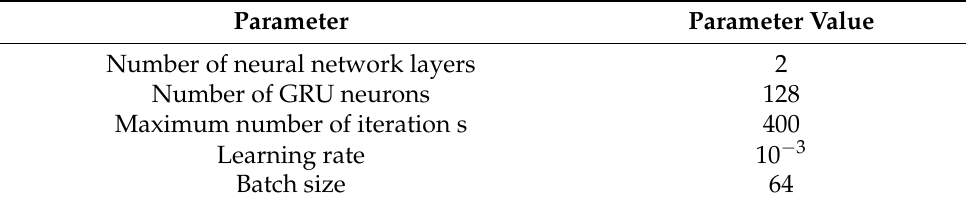
Figure 4. The test loss function varies with the number of iterations. Table 1. Parameter setting.